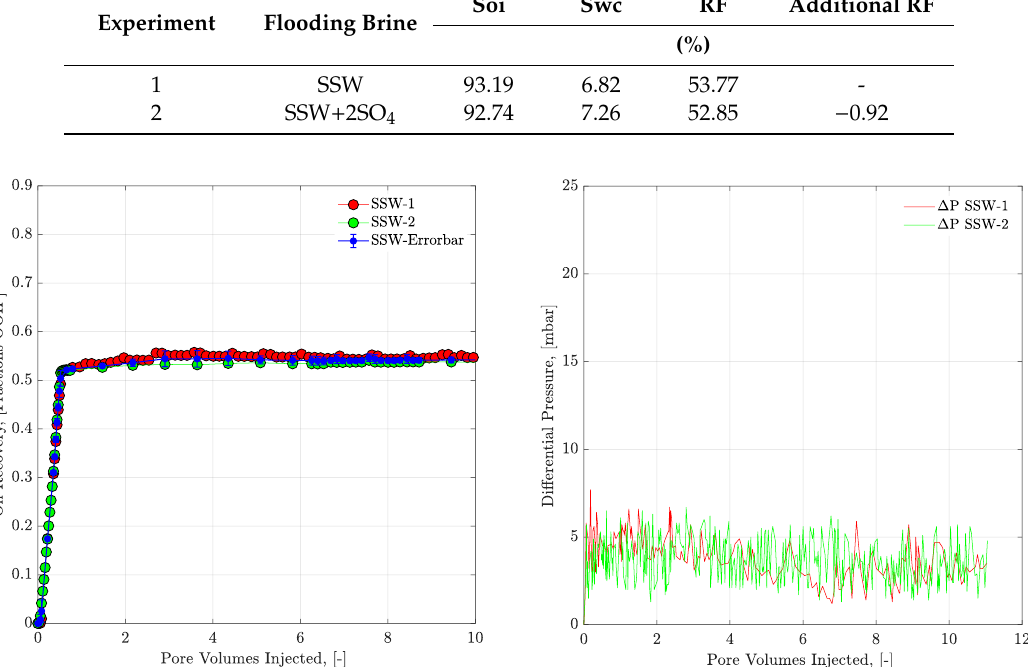
Table 11. Summary of artificial structure water-wet micromodel with initial oil saturation, which connate water saturation and final oil recovery factors.